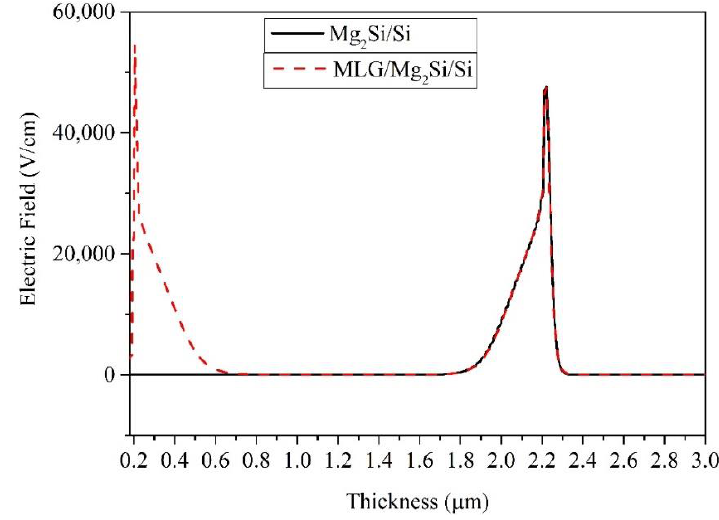
Figure 6. The electric field of Mg 2 Si/Si and MLG/Mg 2 Si/Si PDs.